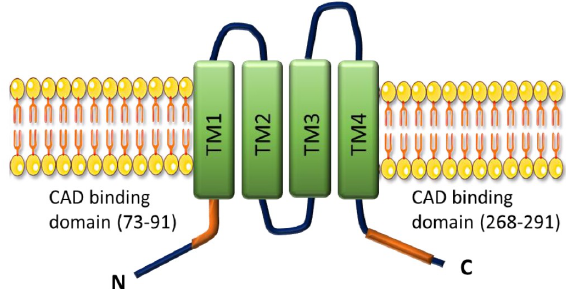
Figure 7. Topology and predicted domains of Orai1 channels. Each Orai1 monomer consists of four transmembrane domains (TM1–TM4) and presents CAD binding domains in the cytosolic NH2 and COOH termini.